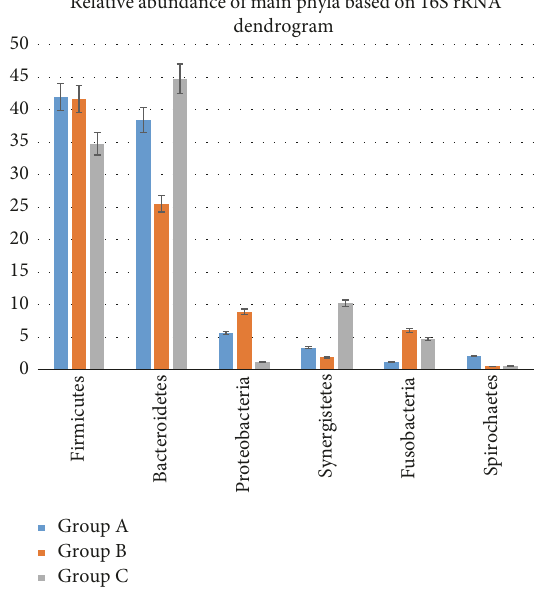
Figure 3: Comparison of the groups (A, B, and C) at the phylum level with error